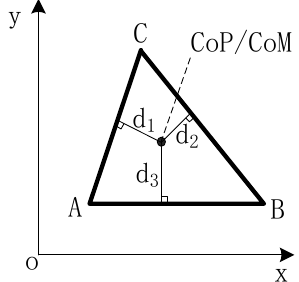
Figure 3. Stability margin of quadruped robot: the shortest distance between the CoP/CoM of robot and each side of the